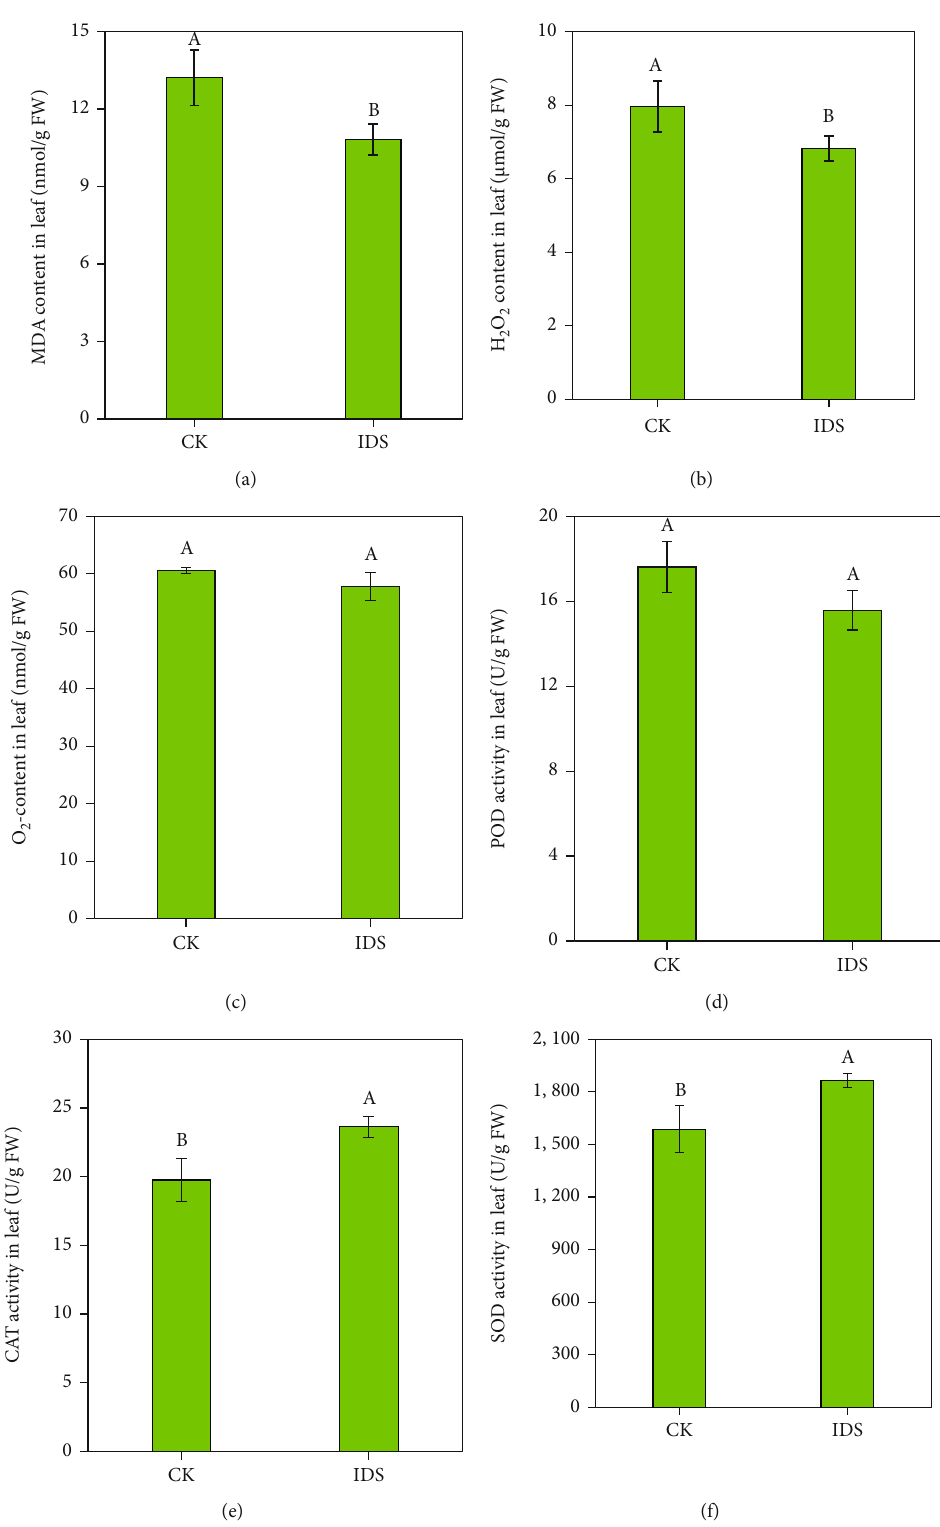
Figure 2: The e ff ects of IDS on MDA, ROS, and antioxidant enzyme system in rapeseed leaves under Cd stress. Mean ± SD ( n = 5 ). Di ff erent uppercase letters (A, B) indicate signi fi cant di ff erence between CK and IDS treatment at P < 0 : 05